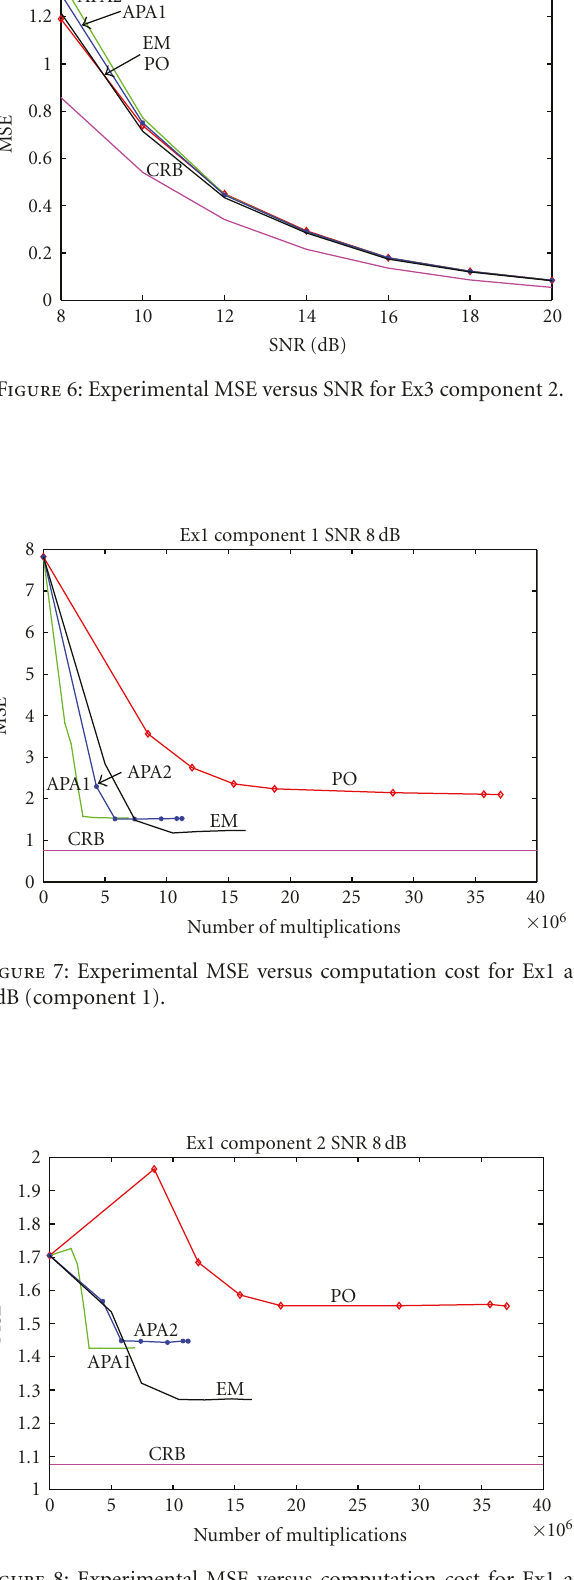
Figure 8: Experimental MSE versus computation cost for Ex1 at 8dB (component 2).